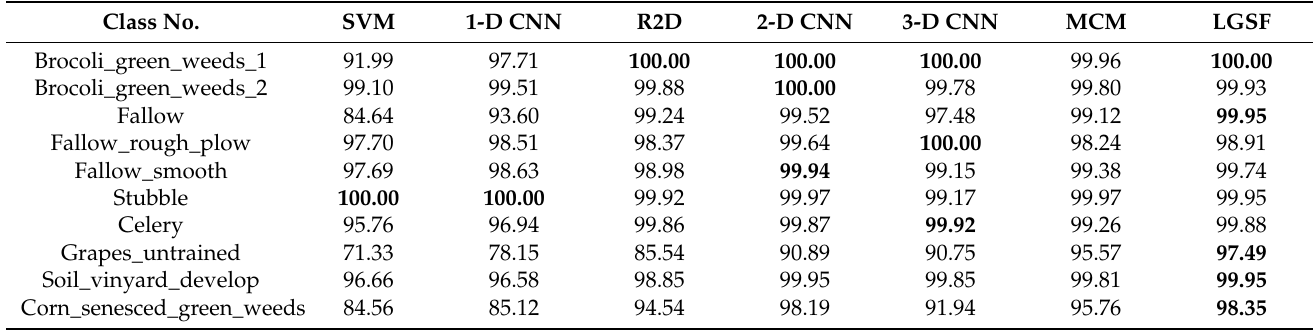
Table 8. Classification results of different methods on the Salinas Valley dataset. (shown in